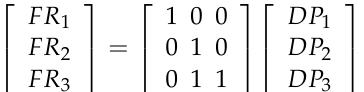
Table 2. Characteristic coefficients of function units.